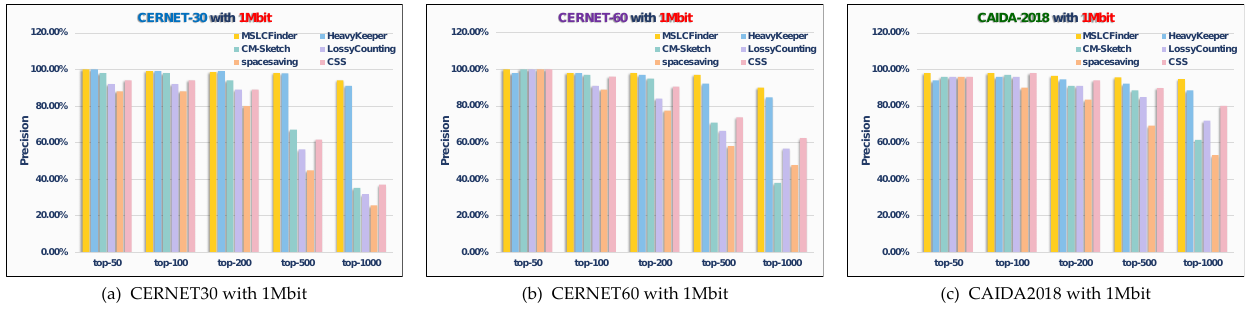
Figure 14. Experiments on precision vs. six methods of three datasets with 1 Mbit. ( a ) CERNET-30 with 1 Mbit. ( b ) CERNET-60 with 1 Mbit. ( c ) CAIDA-2018 with 1